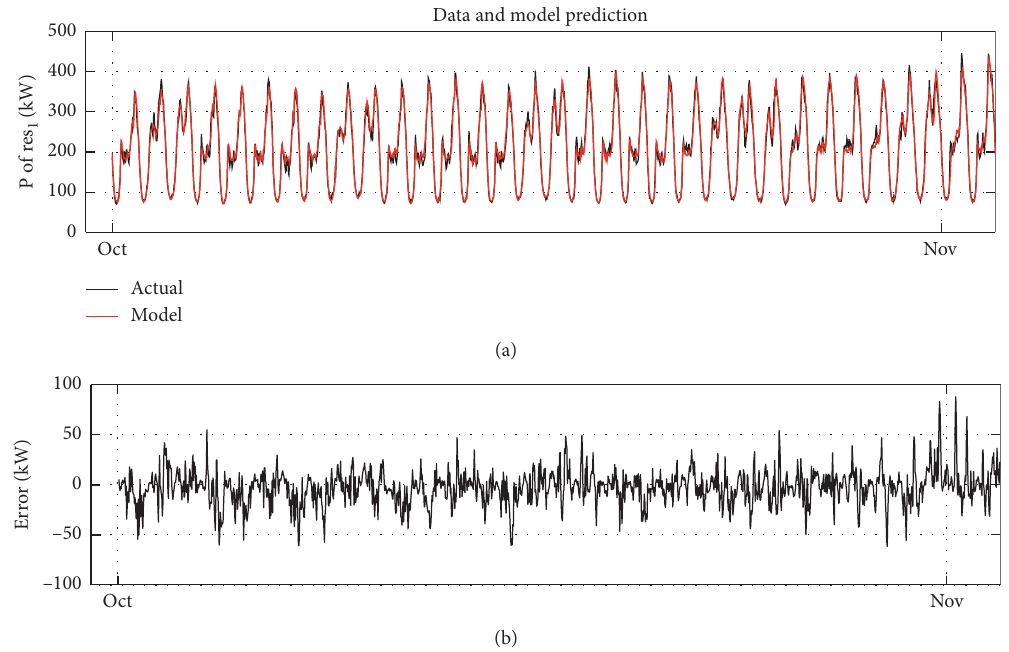
Figure 8: Test set behavior related to res : (a) the red curve represents the predicted real power values and black curve represents the actual 1 one; (b) the differences between predicted and actual load powers.